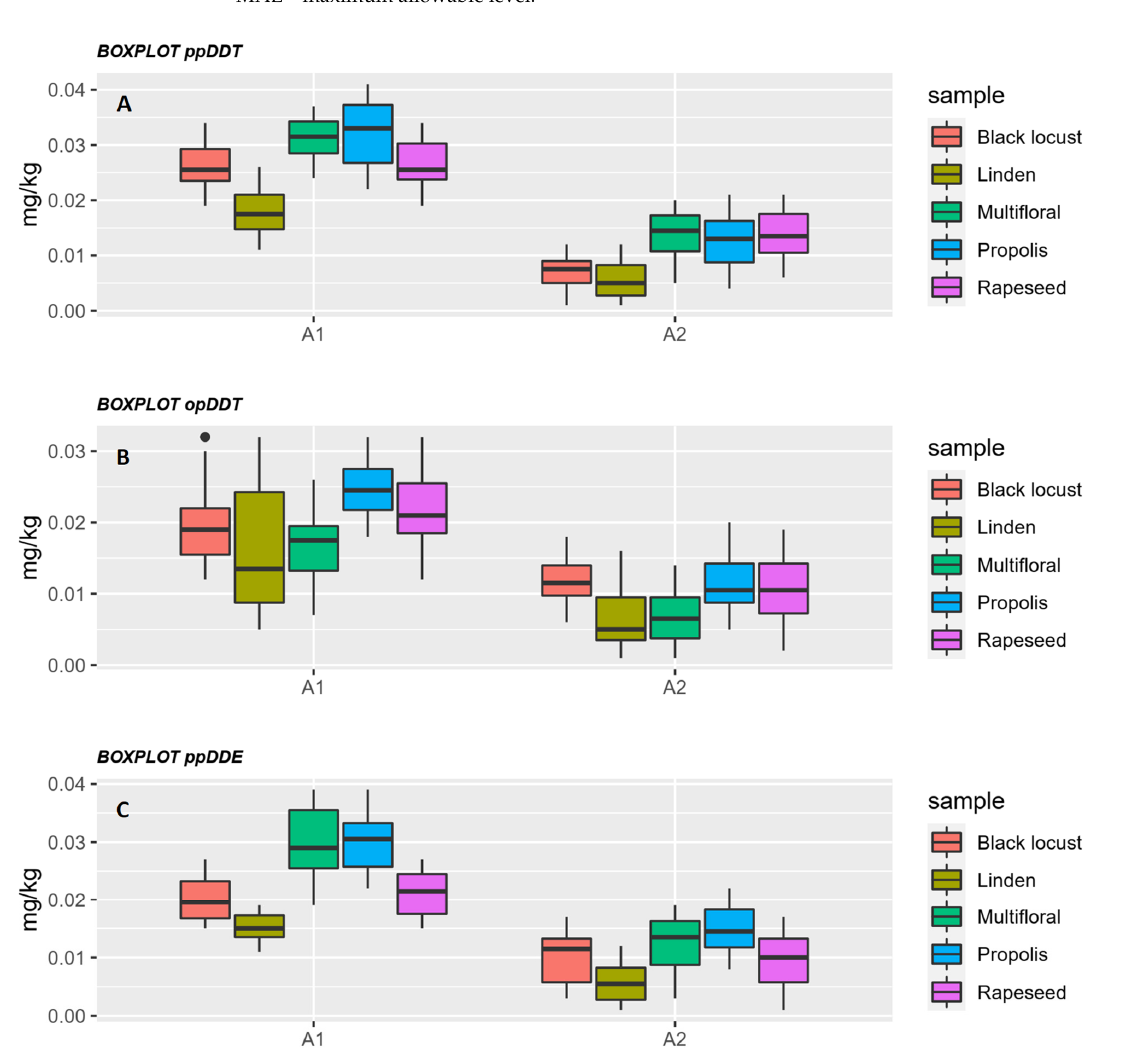
Figure 2. Pesticide level variations in honey samples (mg/kg) in A1 area(industrial activity) and A2 area(agricultural activity): ( A ) p , p ’-DDT, ( B ) o , p ’-DDT and ( C ) p , p ’-DDE.